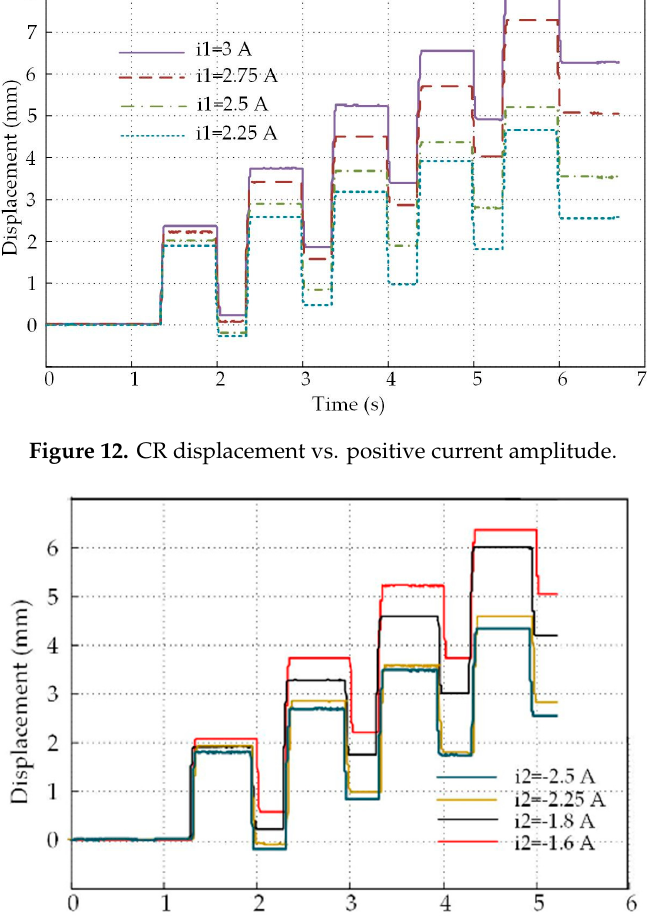
Figure 12. CR displacement vs. positive current amplitude.